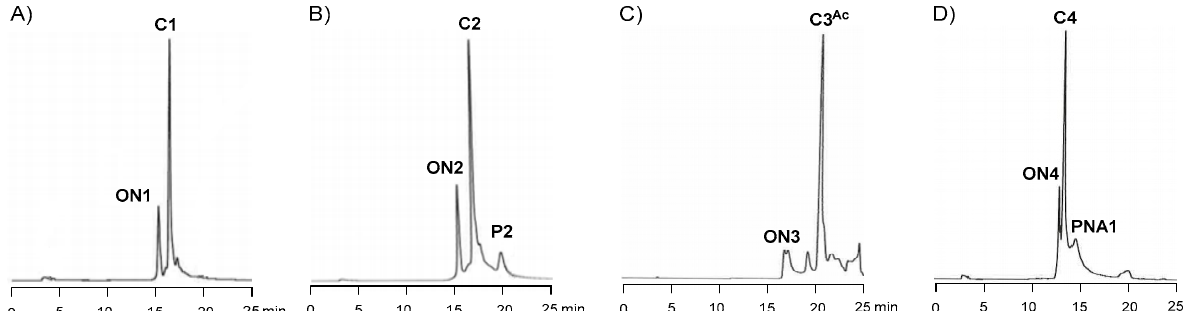
Figure 2 . RP HPLC (C18, 250 × 4.6 mm, 5 µm) profiles of N -methoxyoxazolidine conjugation crude